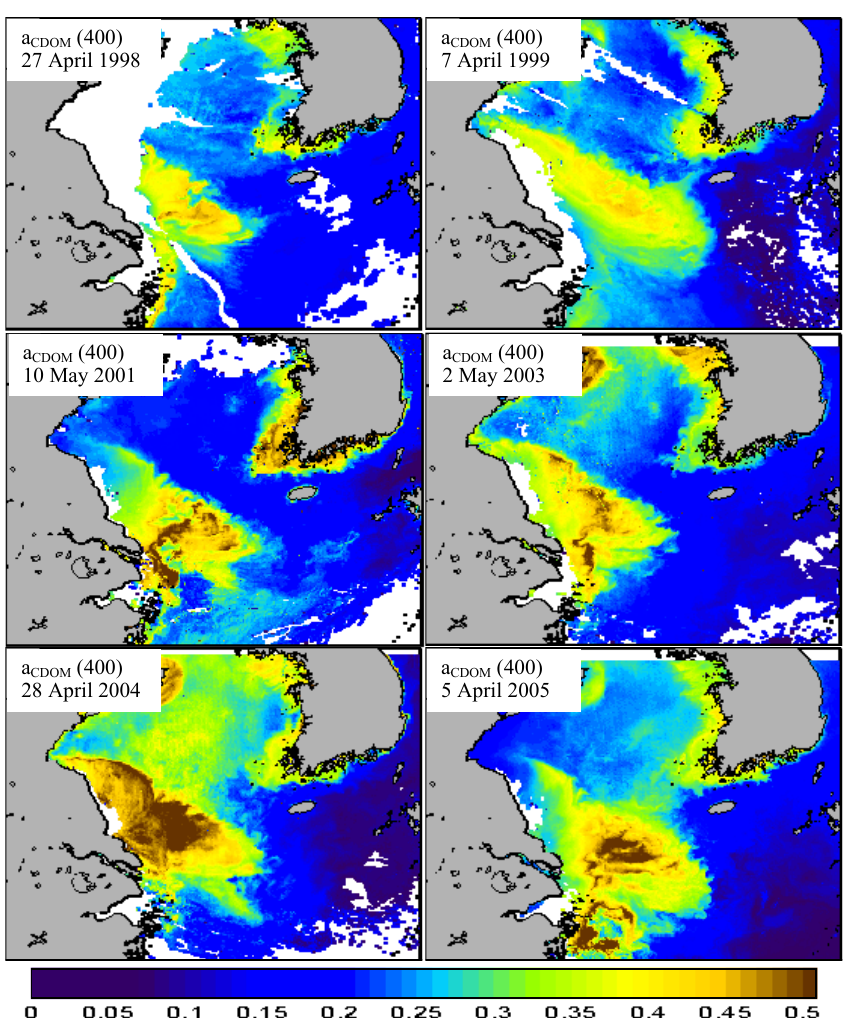
Fig. 7. Maps derived from the SeaWiFS images showing the springtime distribution of coloured dissolved organic matter ( a CDOM at 400nm, m − 1 ) in the ECS, YS and KSS. SSMM atmospheric correction was applied to process these images.